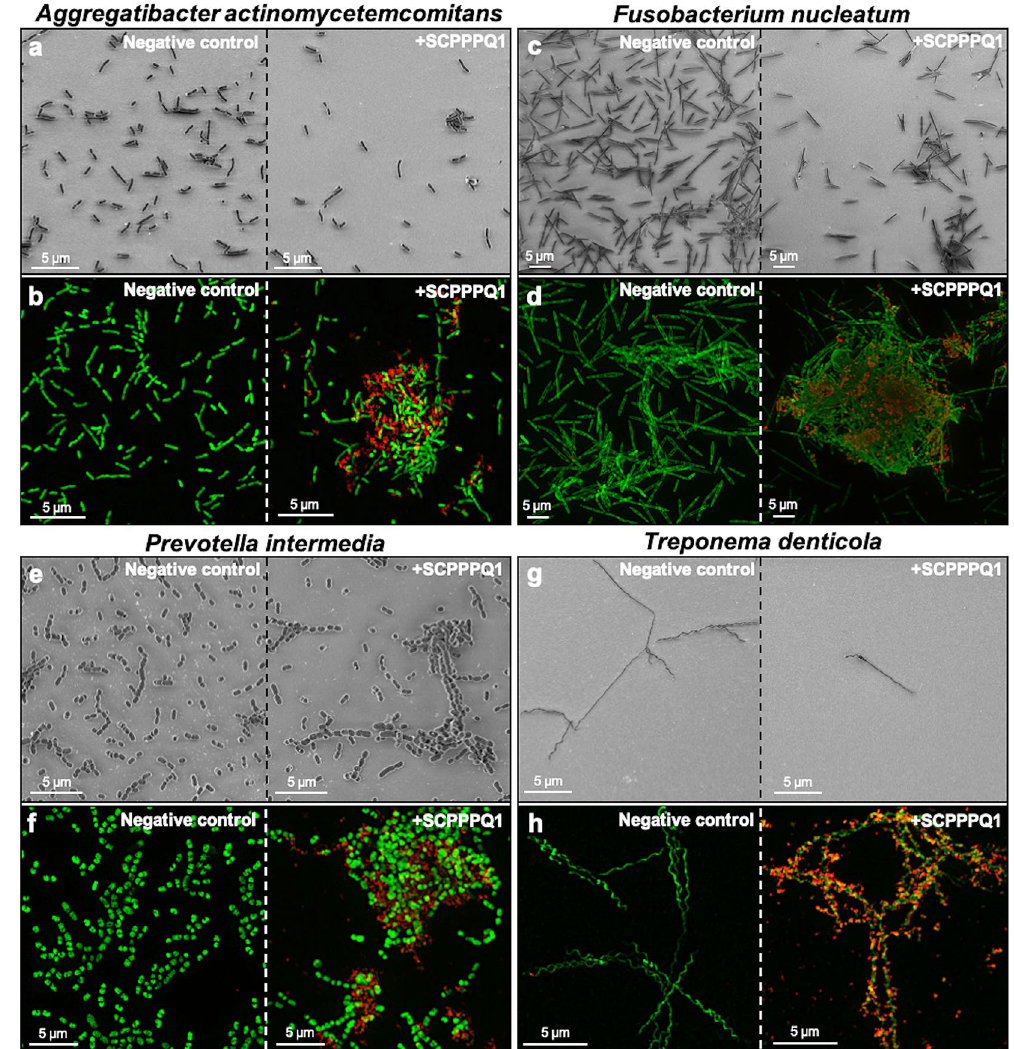
Figure 8. Effect and localisation of SCPPPQ1 on other oral bacteria. ( a,c,e , g ) SEM micrographs and ( b,d,f , h ) Super-resolution fluorescence images of ( a,b ) A. actinomycetemcomitans, ( c,d ) F. nucleatum, ( e,f ) P. intermedia and ( g,h ) T. denticola from the negative control (left) and + SCPPPQ1 treated (right) samples at 20 min. Bacterial nucleic acids were labeled with SYTO 9 (green fluorescence) and SCPPPQ1 with Alexa Fluor-546 secondary antibody (red fluorescence). Images are representative from three different